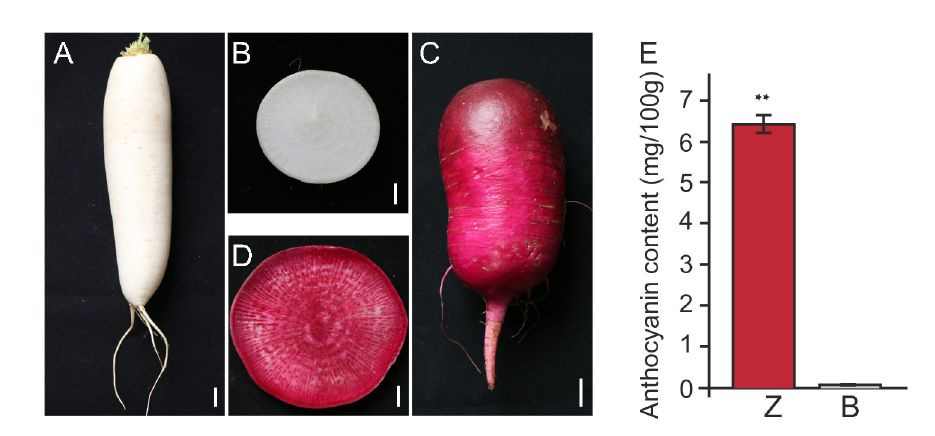
Fig 1. The phenotype of dark red and white radish taproots. A. The epidermis of a white radish taproot; B. Transection of a white radish taproot; C. The epidermis of a dark red radish taproot; D. Transection of a dark red radish taproot; E. Anthocyanin levels in dark red and white radish taproots. A, C Scale bars 2 cm; B, D Scale bars 1 cm. B:BAIXIN; Z:ZIXIN. Error bars indicate standard deviations for three biological replicates. �� reveals significantly different with P <